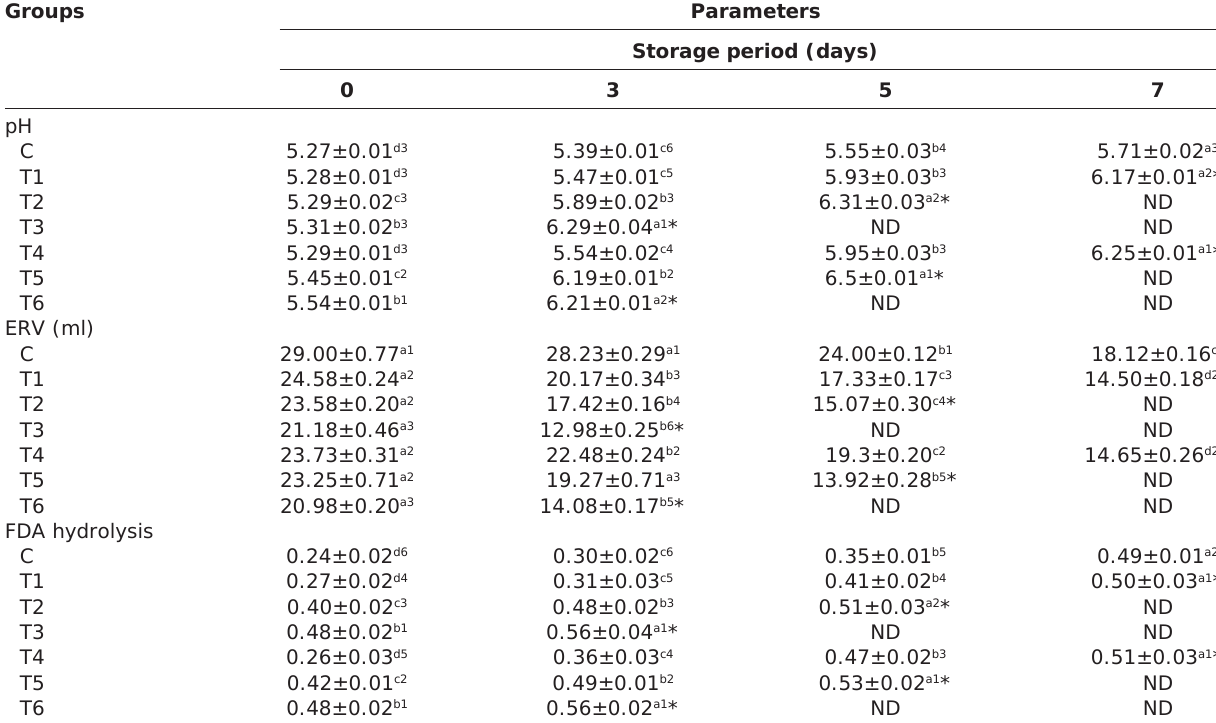
Table-1: pH, ERV and FDA hydrolysis values of control and treatment samples immediately after temperature exposure study and on subsequent refrigerated storage (mean±SE). Groups